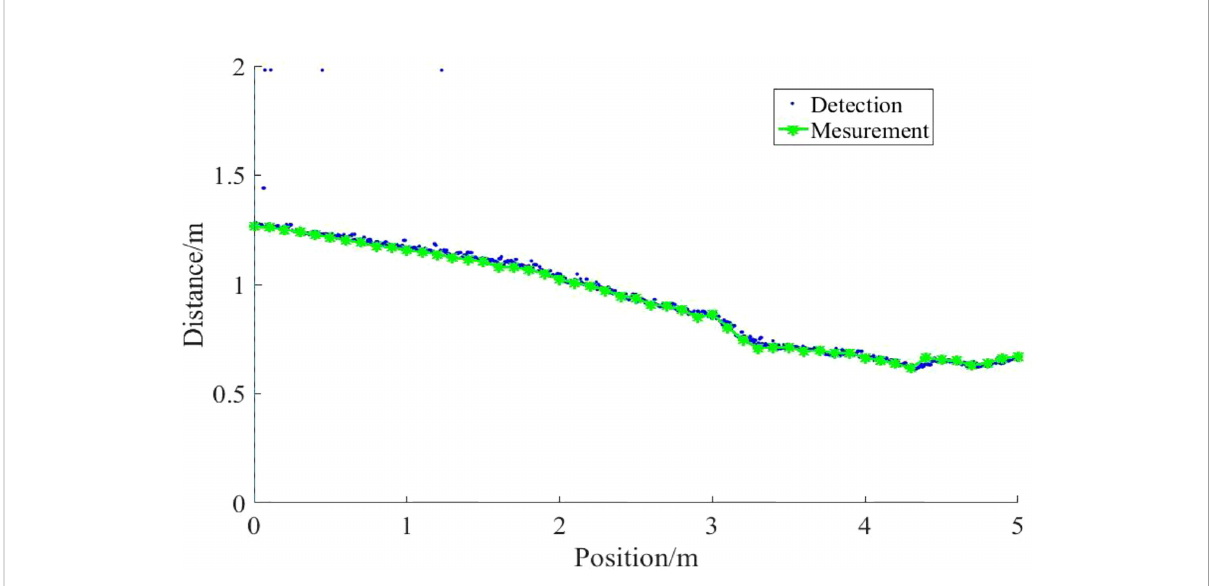
FIGURE 16 Detection distance of ultrasonic sensors on regular step at different speeds. The height detection results of the fi eld ground under manual measurement and quasi-static conditions show that, due to the fl at terrain, the detection results of the ultrasonic sensor on the fi eld ground do not lead or lag behind the actual